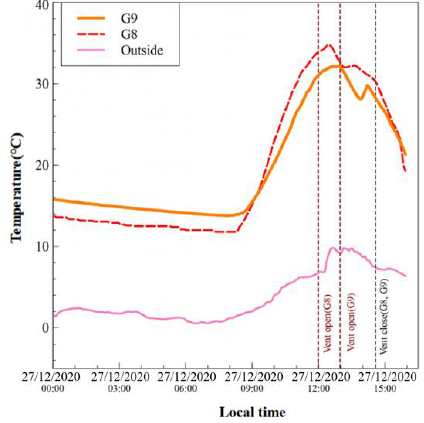
Figure 7. G8 and G9 average temperature data.